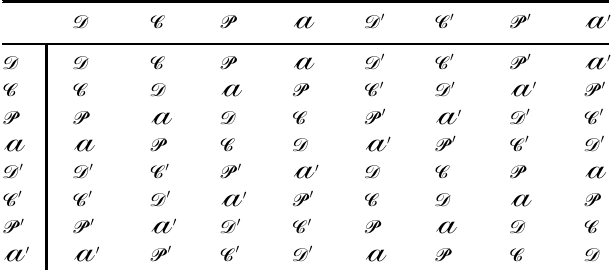
Table 1. Dot product-type SOS relationships among eight kinds of 1D objects (vector- or director-like quantities).